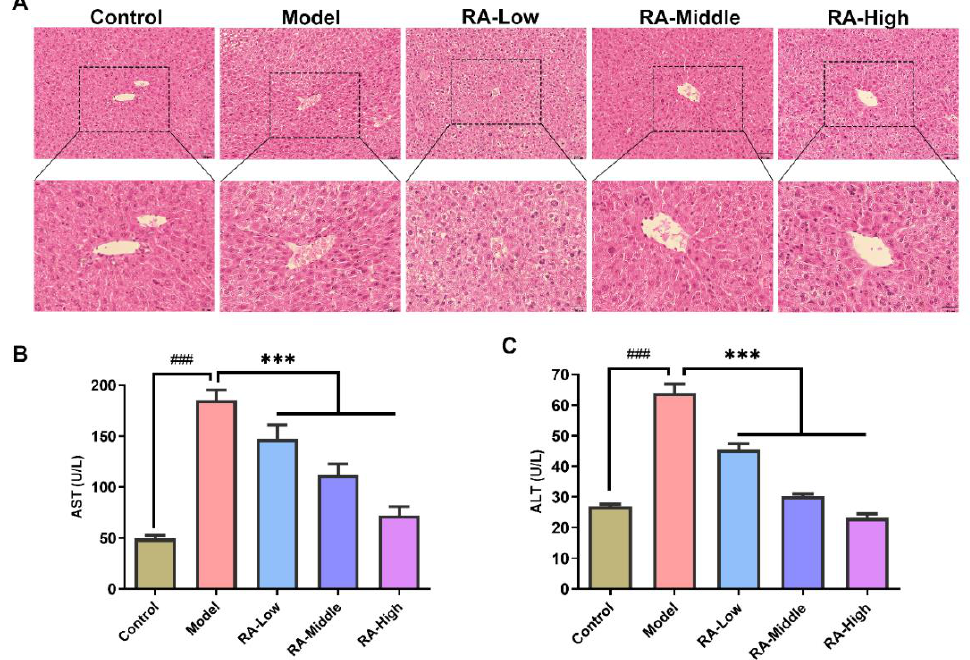
Figure 3. Effects of RA on the serum ALT, AST levels, and liver histopathological features OVA-allergic mice. ( A ) H&E staining analysis of the histological sections of liver. The upper panel: Scale bar = 100 μm. The lower panel: Scale bar = 50 μm. ( B ) Effect of RA on serum AST activity. At day 41, the serum from the caudal vein blood was collected and the activity of AST was measured by the assay kit. ( C ) Effect of RA on the serum ALT activity. ### p < 0.01 compared with the PBS group; *** p < 0.01 compared with the OVA-allergic model group.